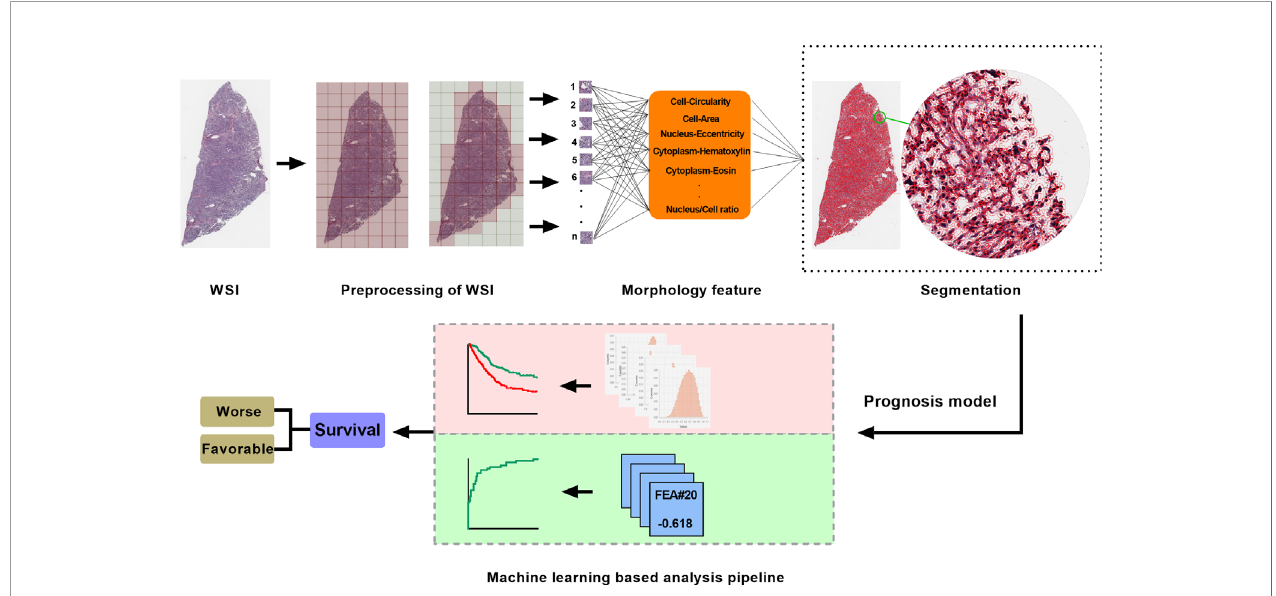
FIGURE 1 | The work fl ow of histopathology image processing and machine learning analysis in this study. WSI, whole slide